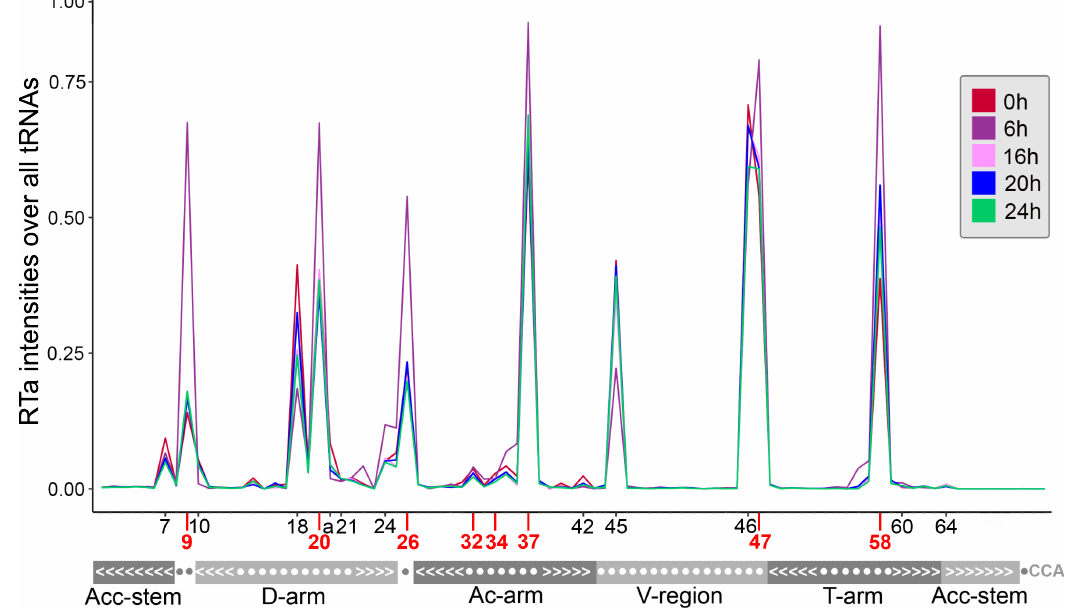
Figure 4. RTa distribution during the life cycle of Dictyostelium discoideum (0, 6, 16, 20, and 24 h). The number of RTa intensities is summarized over all tRNAs and normalized over all reads at each standard tRNA position n (x-axis) (numbered according to Sprinzl et al. [54]). Only RTa sites with an intensity ≥ 20% at the specified position in at least one of the tRNA clusters were considered and are highlighted in black. tRNA positions that show (additional) base-calling mismatches are highlighted in red on the x-axis. The secondary structure of tRNAs is given in dot-bracket notation